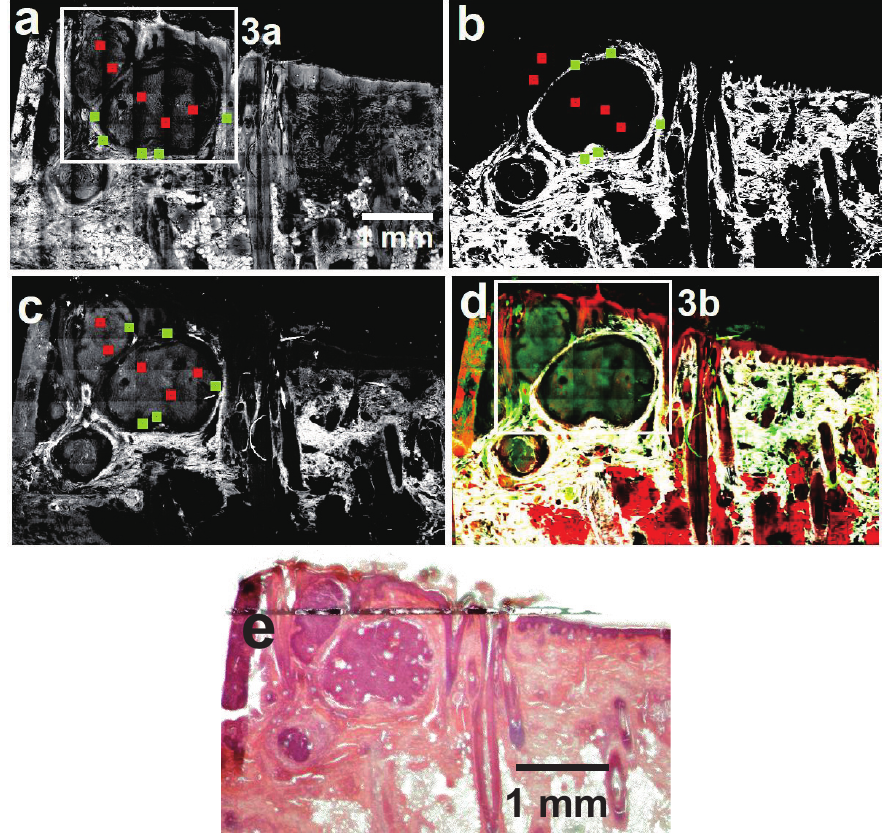
Figure 2. ( a ) CARS; ( b ) SHG; ( c ) TPEF (gray scale) and ( d ) multimodal image (CARS: red; TPEF: green; SHG: grays) as well as ( e ) H&E stained picture of the BBC section. The red (tumorous) and green (non-tumorous) squares locate the position of the 100 × 100 pixel sized areas selected for statistical analysis. ( a ) CARS overview image of a basal cell carcinoma (BCC). The BCC tissue appears darker in CARS. See also Figure 3a for image details encapsulated by the white box; ( b ) SHG image of the same BCC section. In general BCC tissue shows no SHG signal; ( c ) Corresponding TPEF image. BCC tissue appears slightly brighter than the adjacent dermal tissue, but darker than elastin fibers; ( d )